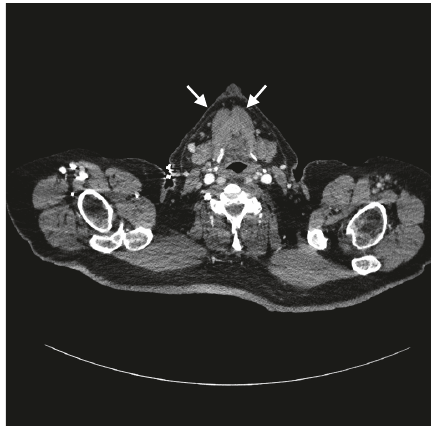
Figure 1: CT scan of neck with contrast showing mildly enlarged and heterogeneous thyroid glands (white arrows) (right > left) with surrounding hazy